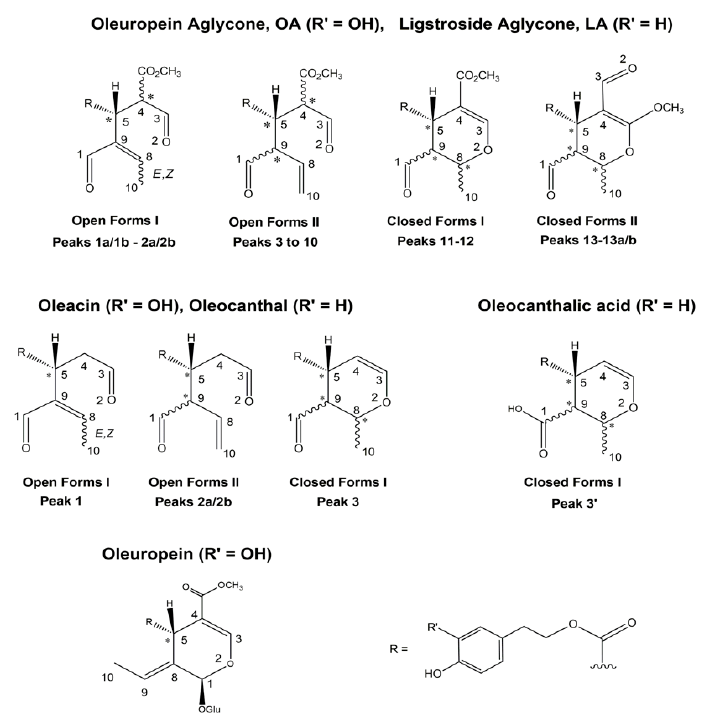
Figure 3. Molecular structures referred to different chromatographic peaks detected in XIC traces of major secoiridoids (see Figure 2), based on the characterization described in Refs. [30–33]. Asterisks indicate stereogenic centers (variable configuration at C 8 and/or C 9 is emphasized by a wavy bond to the methyl group); the E , Z notation is referred to the geometry of the C 8 –C 9 double bond, emphasized by the drawing of a wavy bond between C 8 and C 10 . For the sake of simplicity, enolic/dienolic counterparts, also identified in extracts, were not included in the figure. Note that the numbering of atoms conventionally adopted for secoiridoids in the literature has been used.